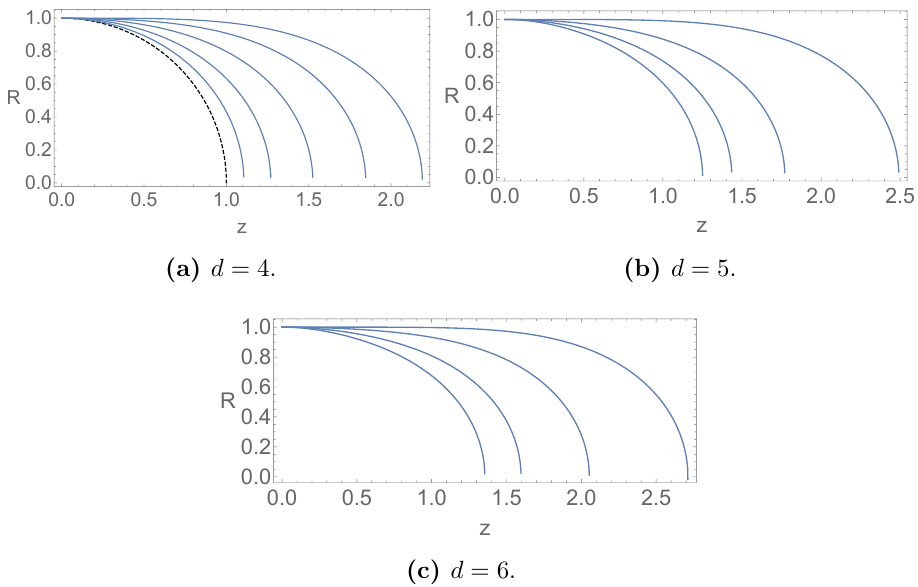
Figure 1. In (a){(c), we embed the horizons into the metric ds 2 = l 2 (a), we choose (from right to left) R (cid:0) =R + = 0 ; : 2 ; : 5 ; : 8 ; : 96 ; 1 : 0. The extremal black hole is the dotted black line. In (b) and (c), we choose (R to L) R (cid:0) =R + = 0 ; : 5 ; : 7 ; : 8. Notably, the extremal horizon in d = 4 is a minimal surface in the pure AdS where it is